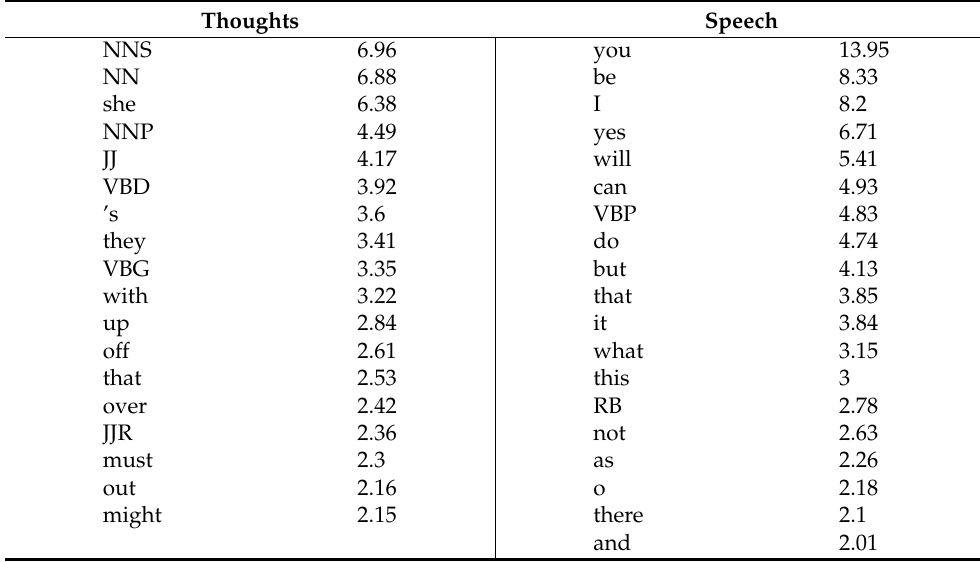
Table 3. Adjusted Pearson residuals for Bloom’s thoughts and